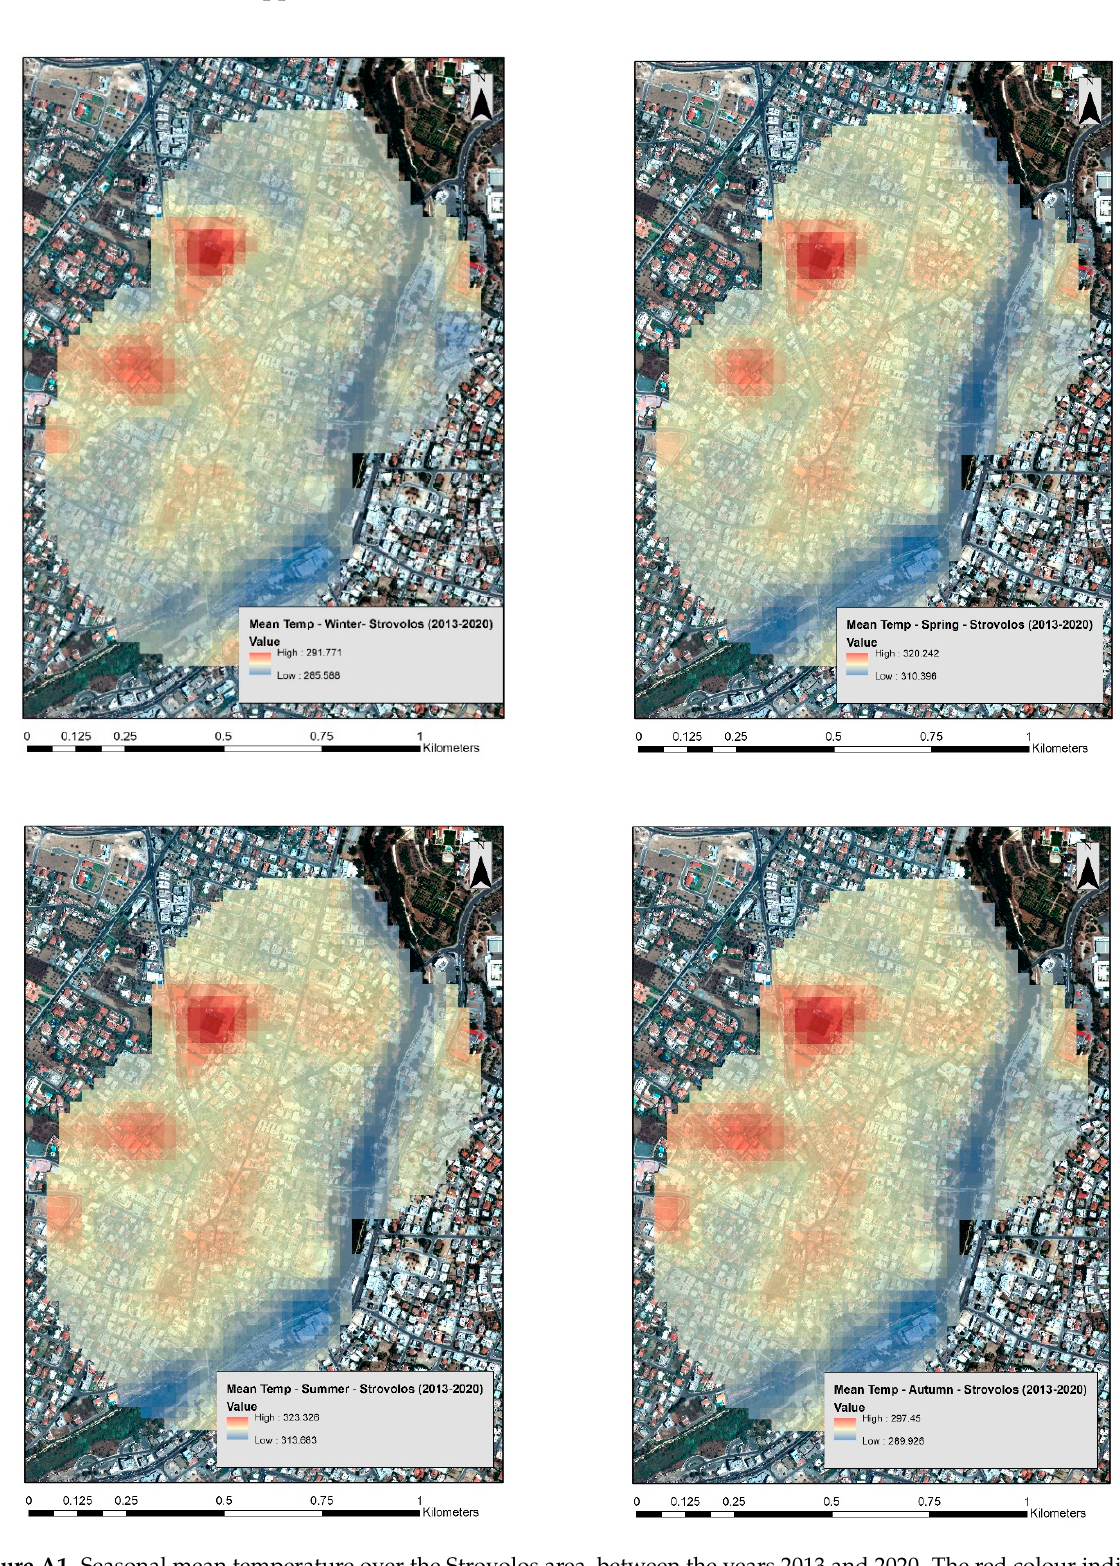
Figure A1. Seasonal mean temperature over the Strovolos area, between the years 2013 and 2020. The red colour indicates higher mean temperatures, while the blue colour indicates lower mean temperatures.